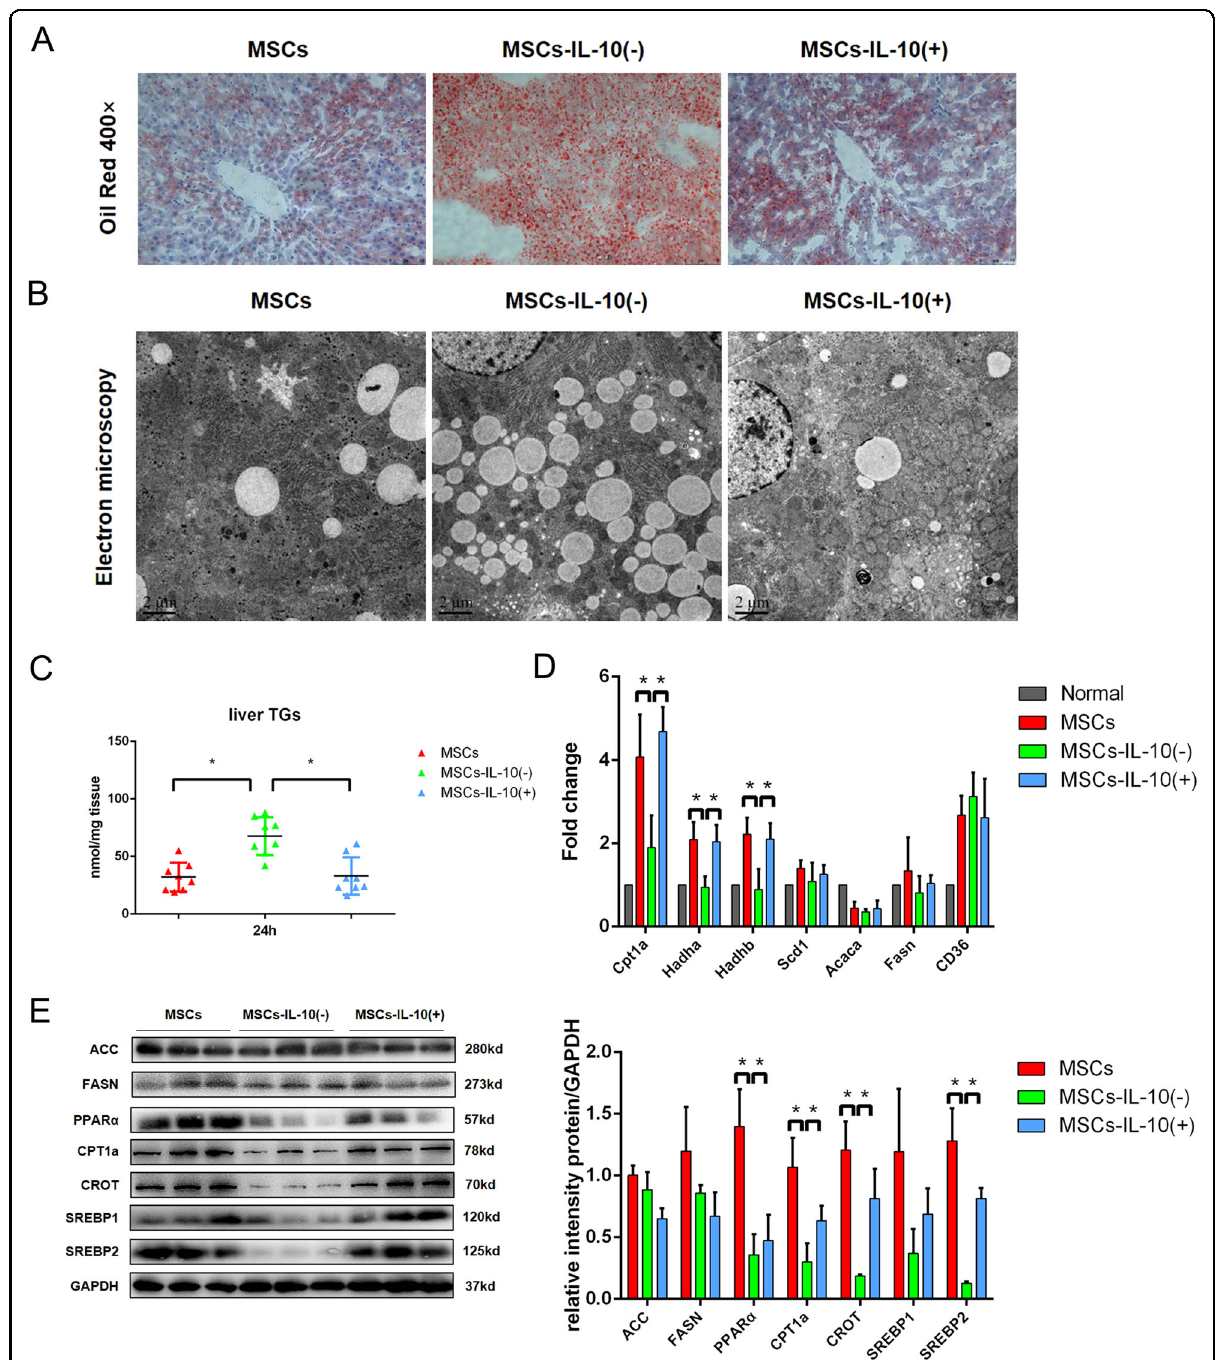
Fig. 7 MSCs affect lipid metabolism in PHLF by secreting IL-10. A Oil red staining of liver tissue. B Electron microscopy of liver tissue. C Detection of TG content in liver tissue. D , E Western blotting analysis and RT-PCR of liver lipid metabolism-related genes and proteins. * P < 0.05. t -test, data are shown as mean standard